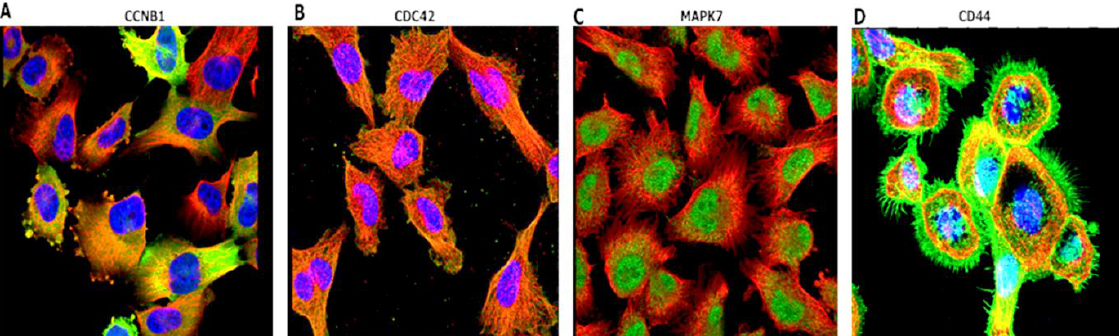
Figure 6. HPA staining results of the U251-MG cell line exhibited the locations of genes. Antibodies are shown in green, nuclei in blue, and microtubules in red. ( A ) CCNB1 was localized in the cytosol, ( B ) CDC42 was detected in microtubules, ( C ) while the localization of MAPK7 was in the nucleoplasm, and ( D ) CD44 was found in plasma membranes. All images are available online.